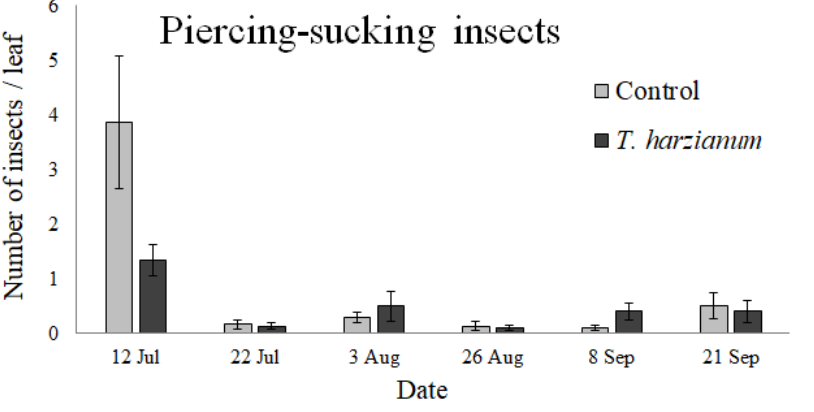
Figure 4. Mean values (± standard errors) of piercing-sucking insects collected on tomato leaves during the experiment.